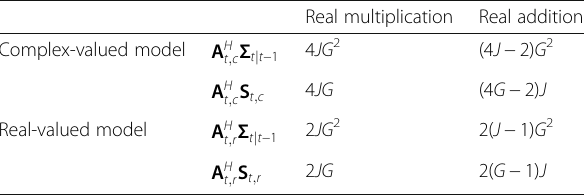
Table 1 Comparison of computational load in one